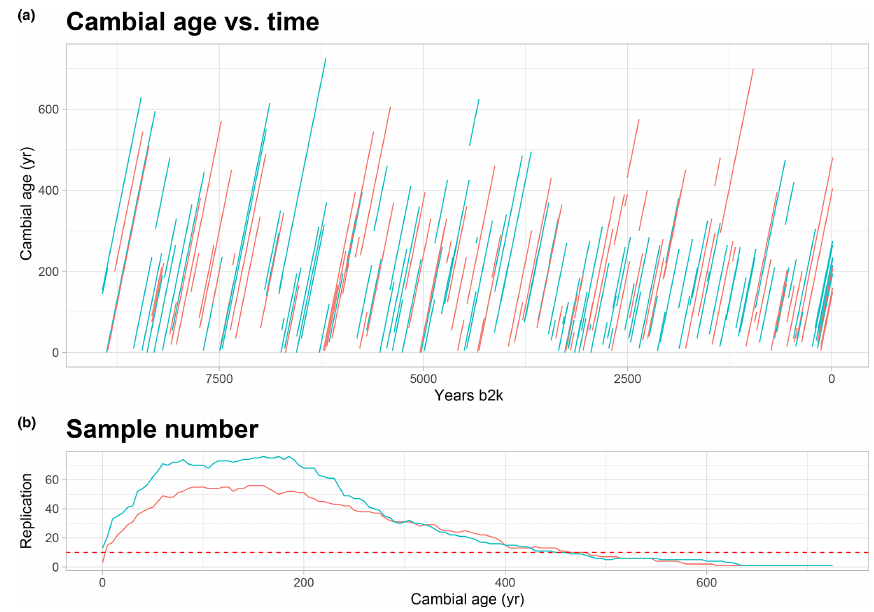
Figure 2. Cambial age and replication: (a) graph of temporal distribution of the all trees and their cambial age. On the x axis the calendar age of the time series is displayed, which goes back to 9000 years; on the y axis is the cambial age. Each line represents a tree, in red the larch and in green the cembran pine. (b) Graph of the replication along the cambial age. The dotted line represents the threshold of 10 that we have considered for the